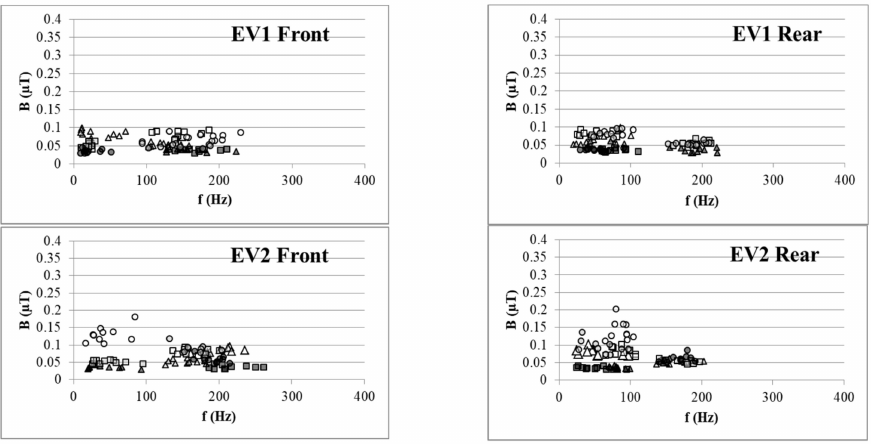
Figure 3. Measured spectral components (SCs) from the acceleration sessions at rear and front seats. The signs in the caption are formed of four digits representing the measurement year and three digits representing the specific SC, e.g., 2019SC3 indicating the third highest spectral component from the measurement in